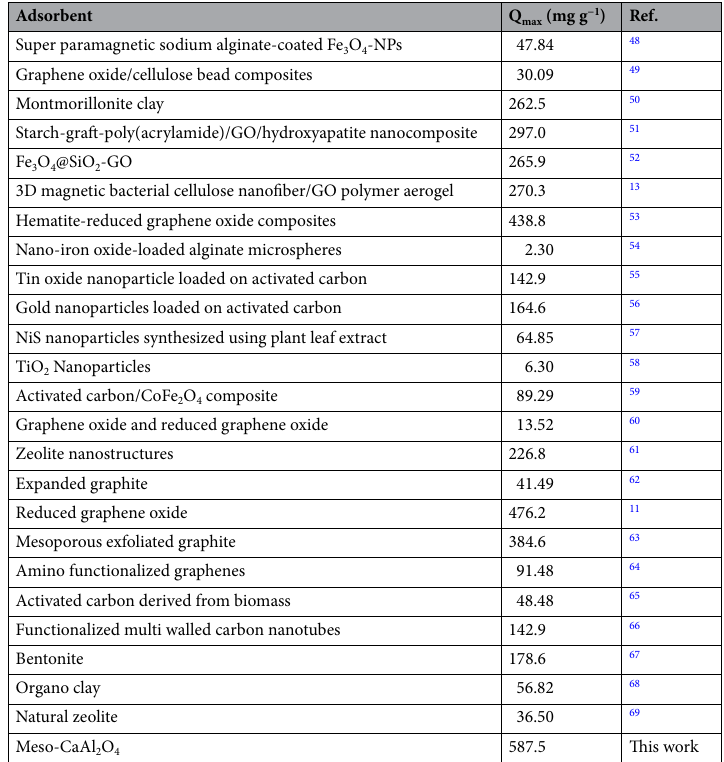
Table 4. Comparison of meso-CaAl 2 O 4 with other materials reported in the literature for MG dye adsorption (estimated by Langmuir isotherm).